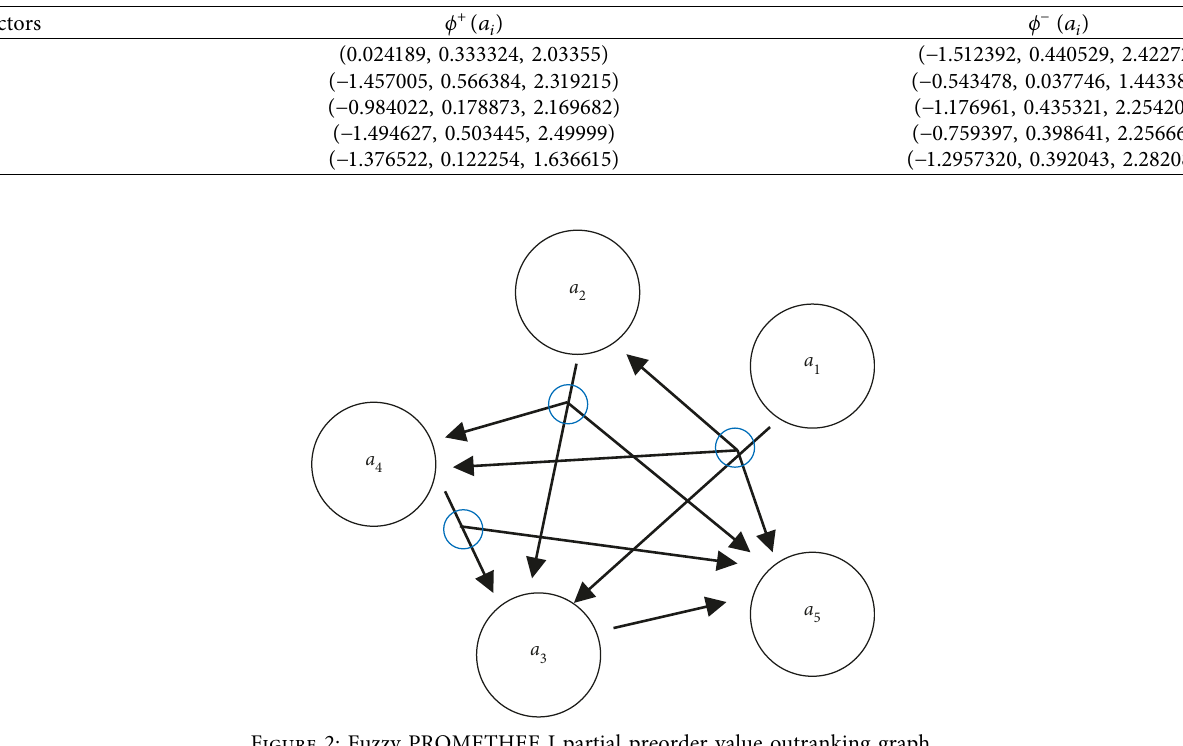
Table 15: Fuzzy PROMETHEE I flow.